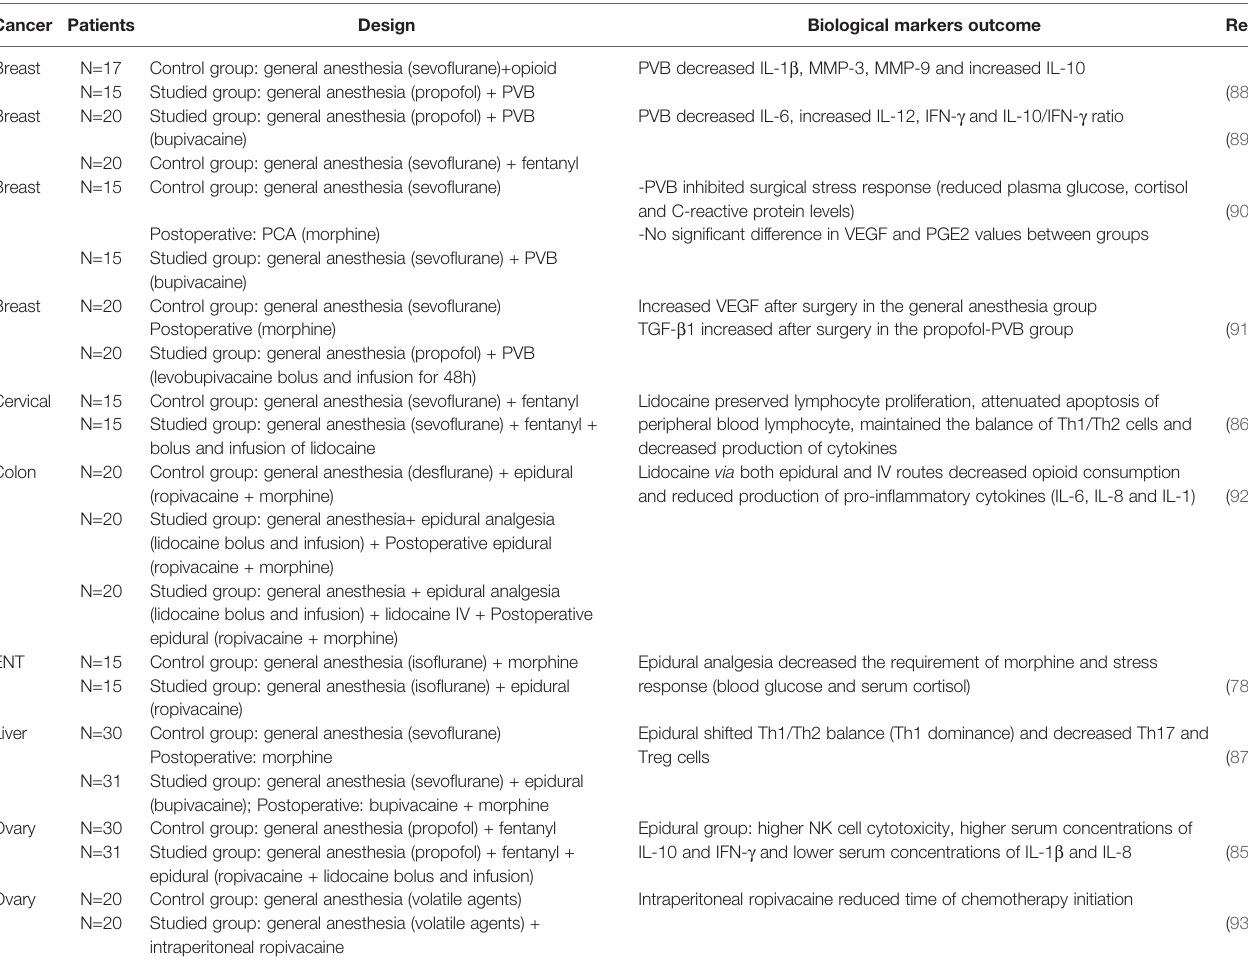
TABLE 1 | Trials assessing local anesthetics on biological markers. Cancer Patients Design Biological markers